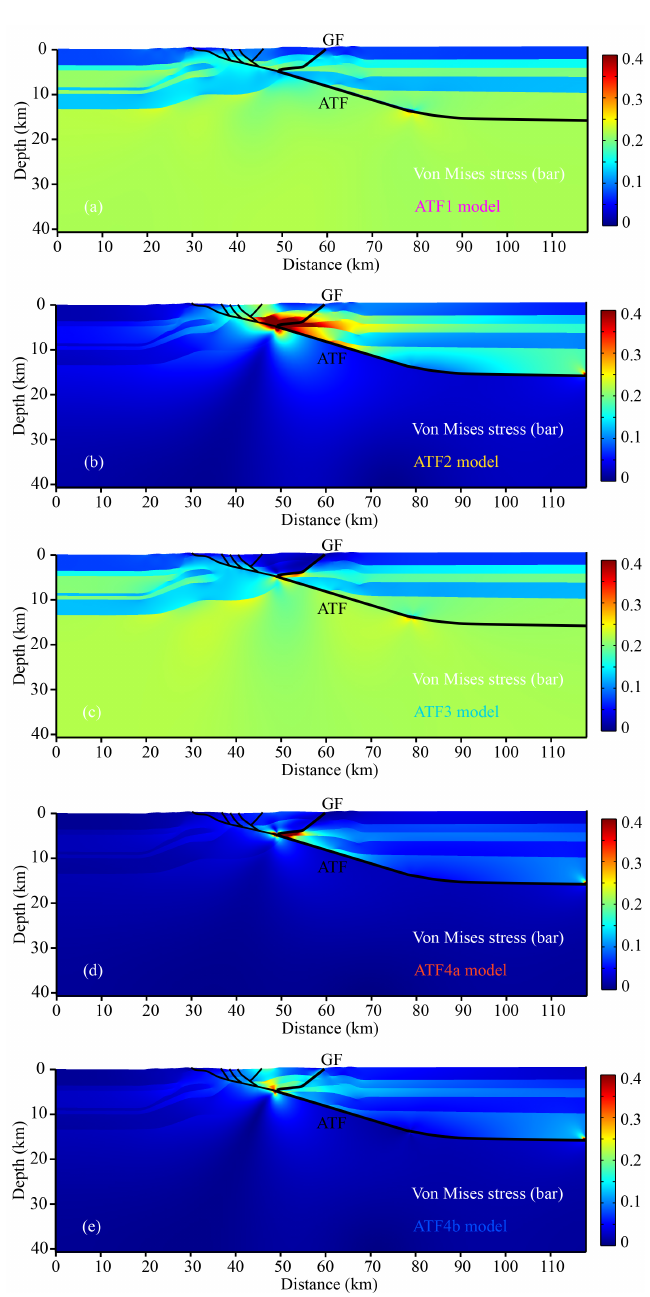
Figure 5. 2-D cross sections of the Von Mises stress distribution derived from the different models.